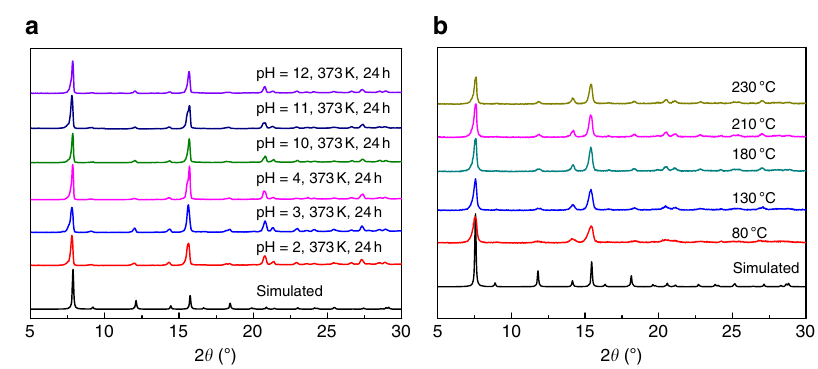
Fig. 2 Stability of FJI-H14. a PXRD patterns after treatment with boiling water, acid/base environment from pH = 2 to 12 at 373 K. b Temperature- dependent PXRD patterns